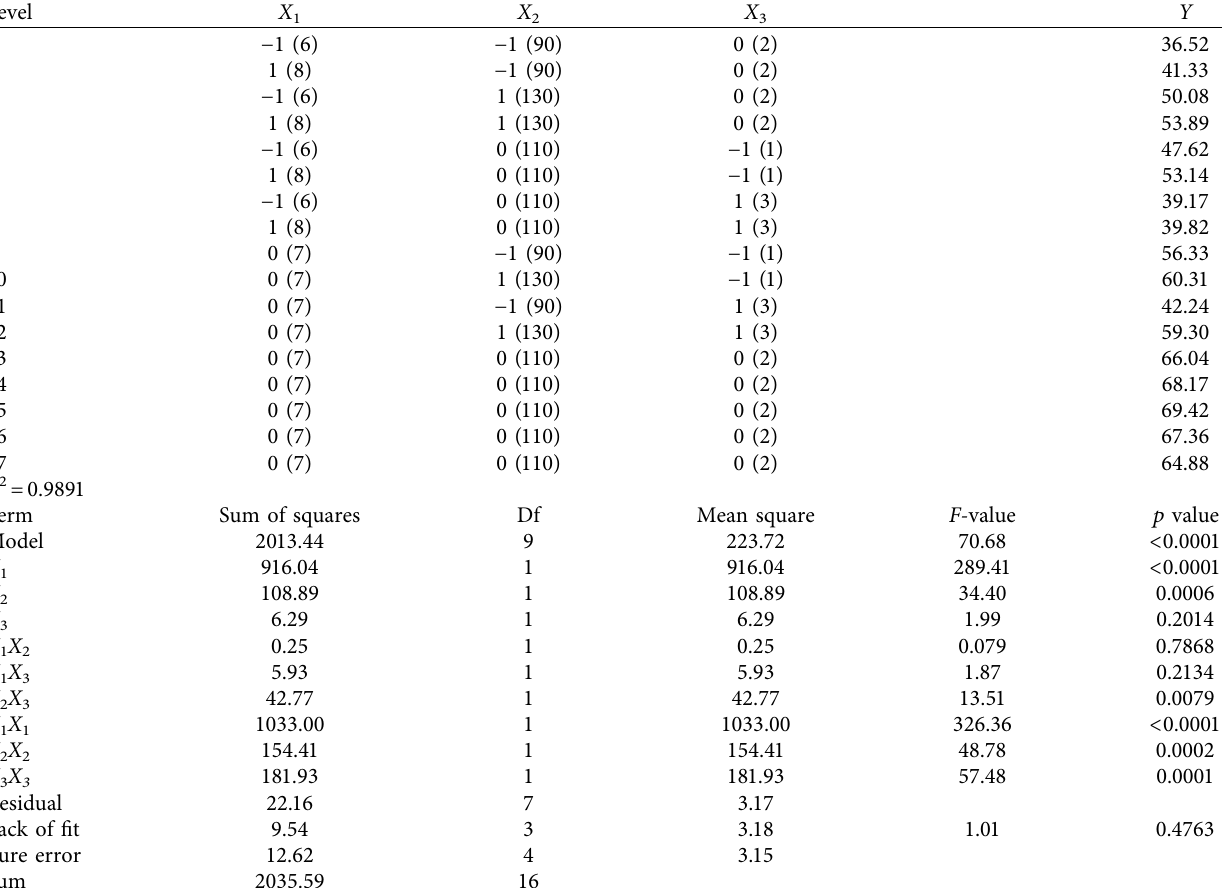
Table 1: Box-Behnken design and results of Maillard reaction of protein hydrolysate from grass carp bone.